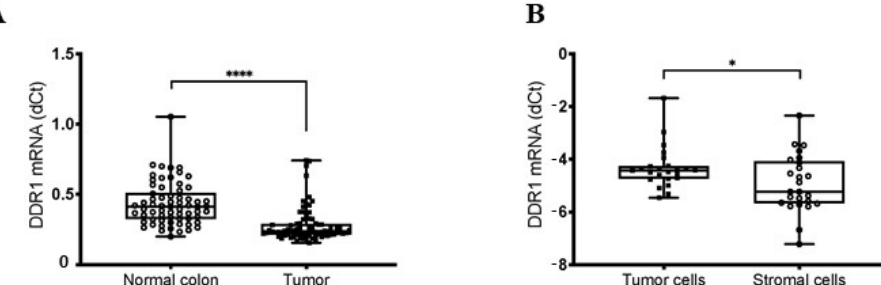
Figure 5. Comparison of DDR1 mRNA expression between tumor cells, normal colon and stromal cells. ( A ) Real-time PCR analysis of the DDR1 mRNA expression performed in colon adenocarcinoma and in normal colon mucosa fresh frozen samples. Values are represented as dCt normalized with RPL32. ( B ) Real-time PCR analysis of the DDR1 mRNA expression performed in adenocarcinoma cells and in stromal cells after laser capture microdissection. Values are represented as dCt normalized with RPL32. * p < 0.05, **** p < 0.0001, Mann Whitney test.